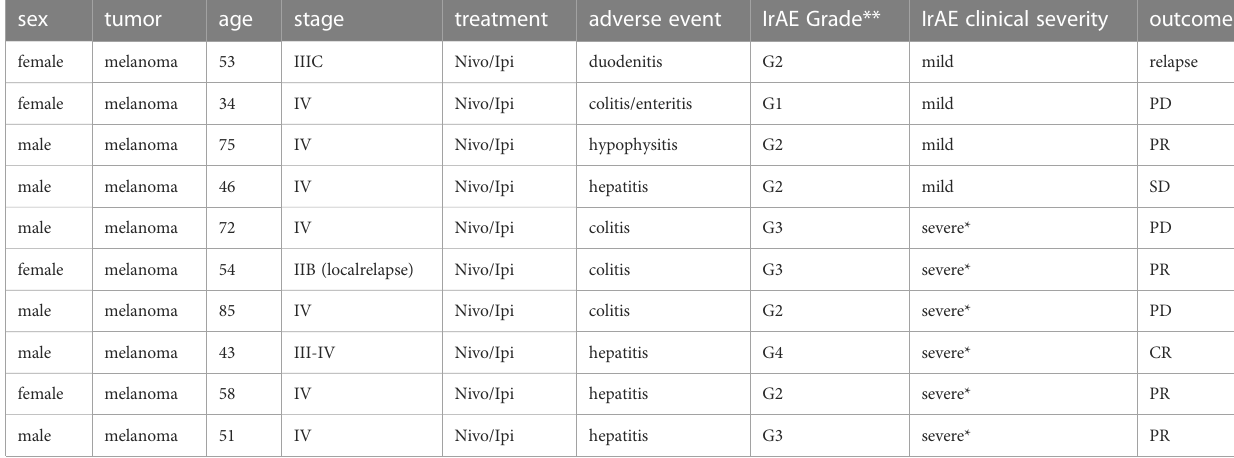
TABLE 2 Patients receiving PD-1 and CTLA-4